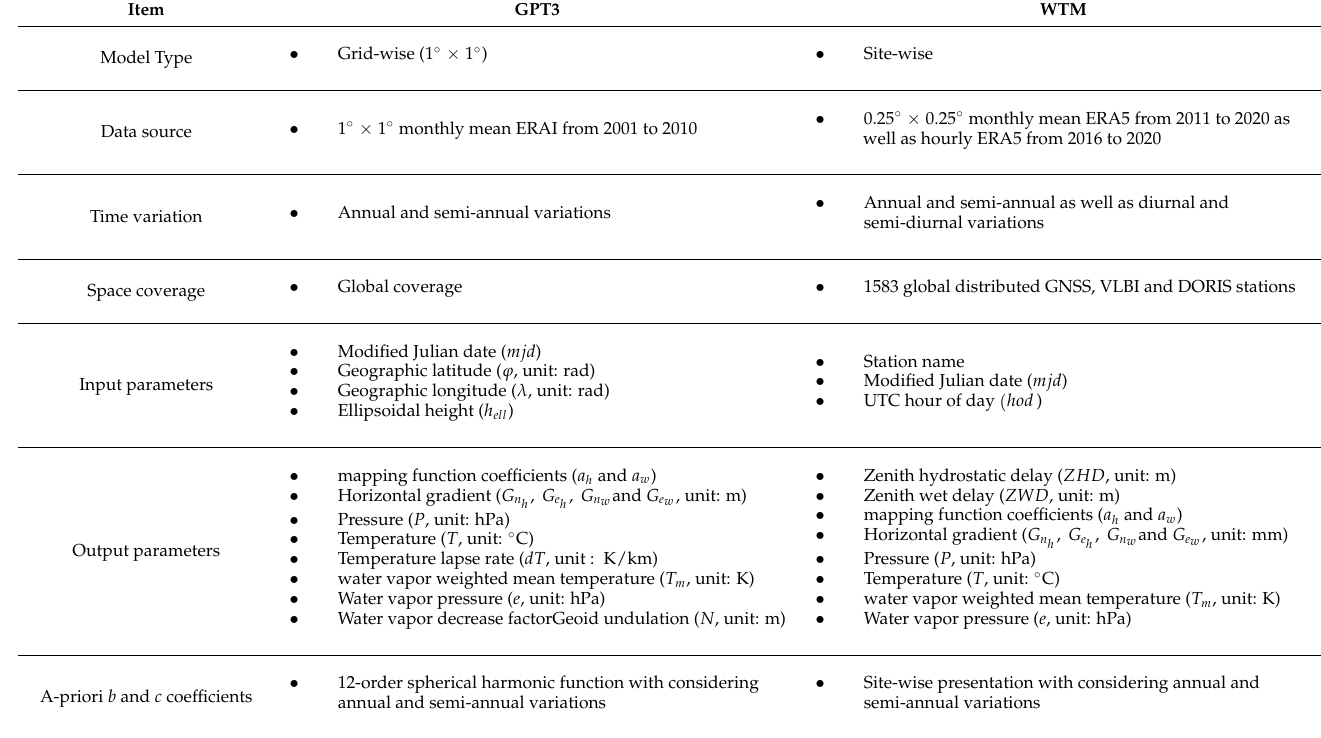
Table 1. Signatures of the GPT3 model and the newly established WTM